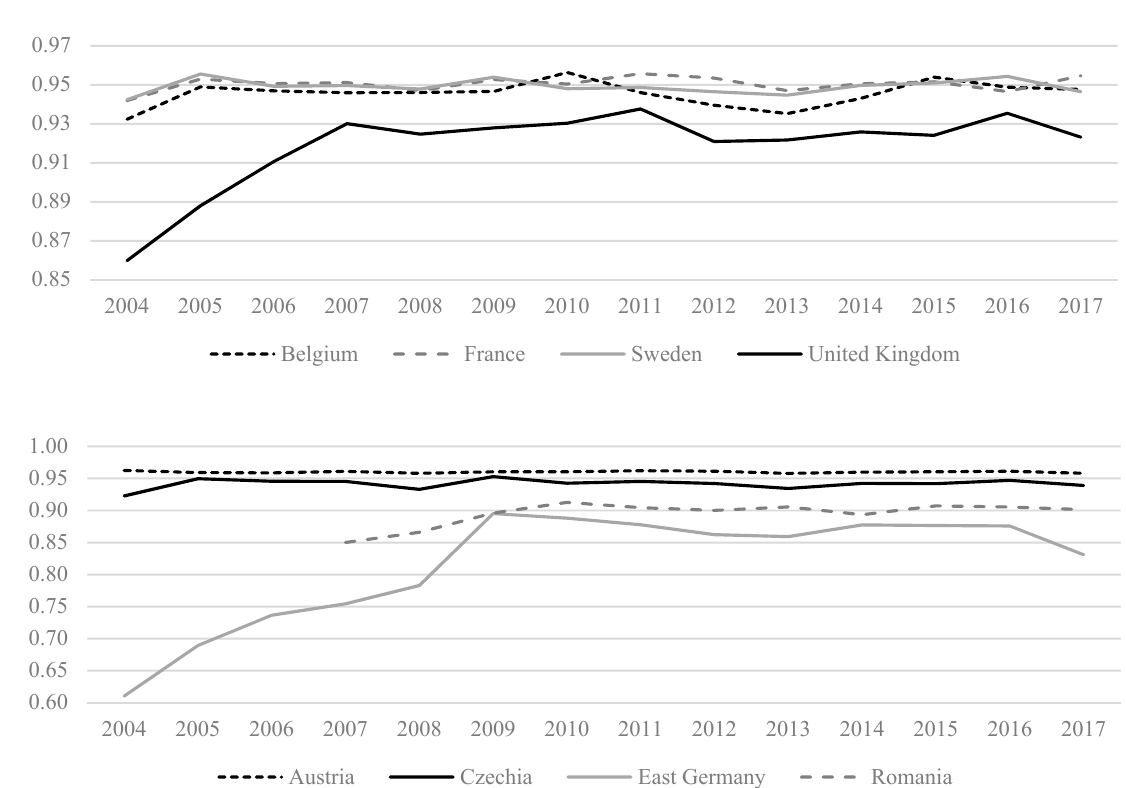
Figure 4. Transient technical efficiency development. Source: authors’ own calculations.